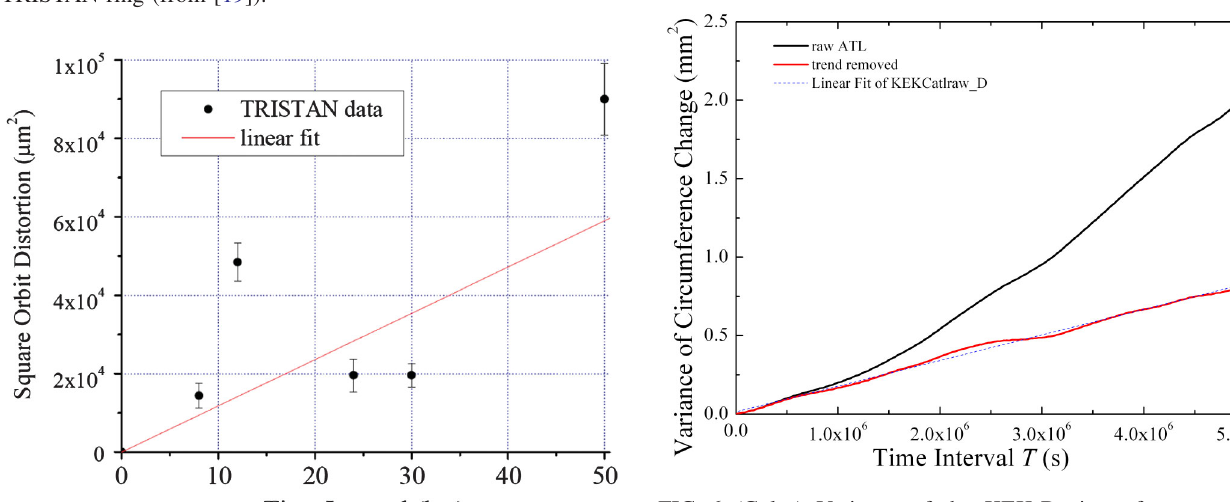
FIG. 6. (Color) Variance of the KEK-B circumference varia- tions; the black line is for raw data, the red line is for the data with linear trend subtracted, and the dashed line is a linear